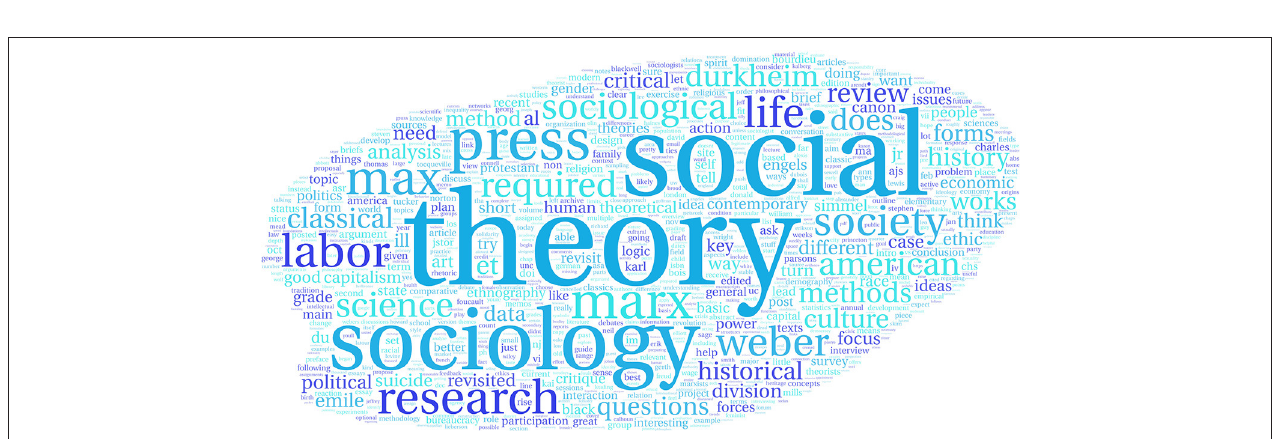
FIGURE 1 | A word cloud created from 13 syllabi and course descriptions of undergraduate introductory sociology courses from the top 12 programs (including an additional honors program).